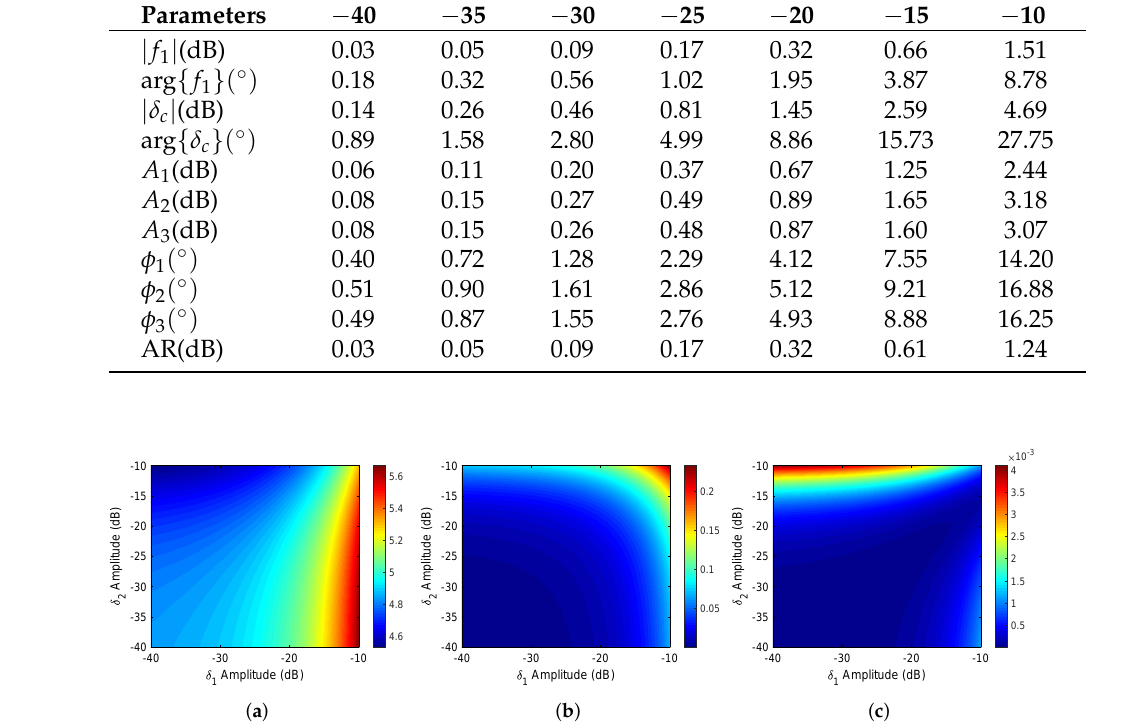
Figure 6. The dissimilarity between measured scattering vector and the theoretical receiving vector containing only transmission errors. ( a ) Original measured scattering vector. ( b ) Measured scattering vector corrected by ICT scheme. ( c ) Measured scattering vector corrected by CCT